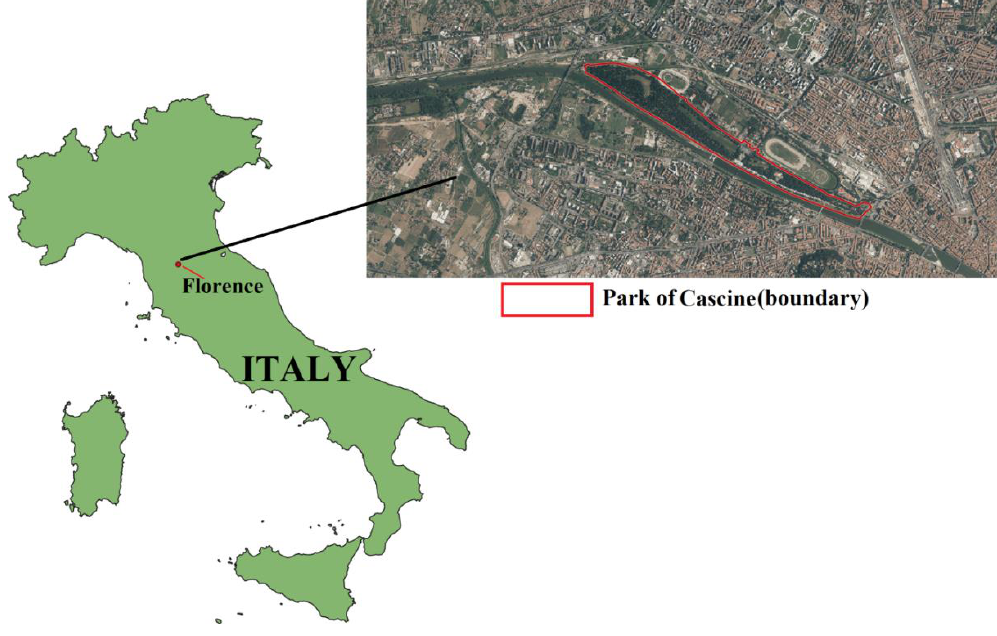
Figure 1. Study area. Source: Own elaboration.